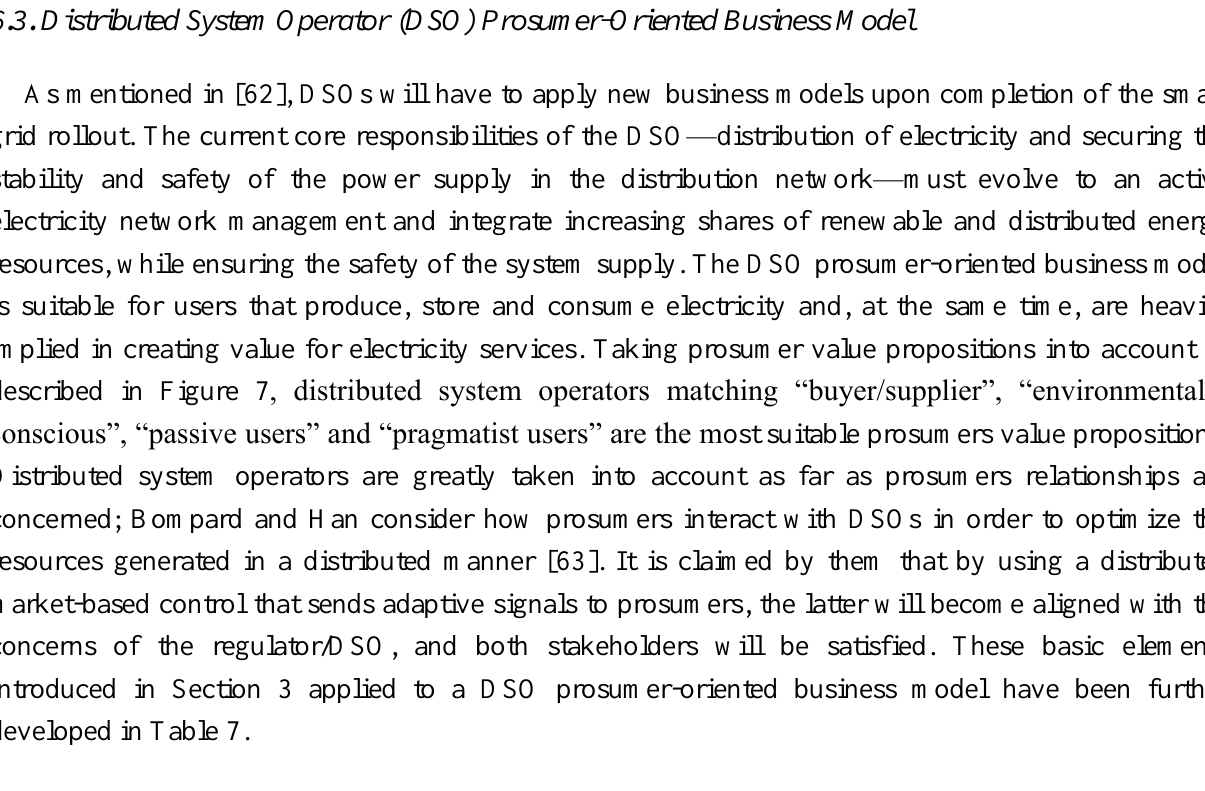
Table 7. DSO prosumer-oriented business model